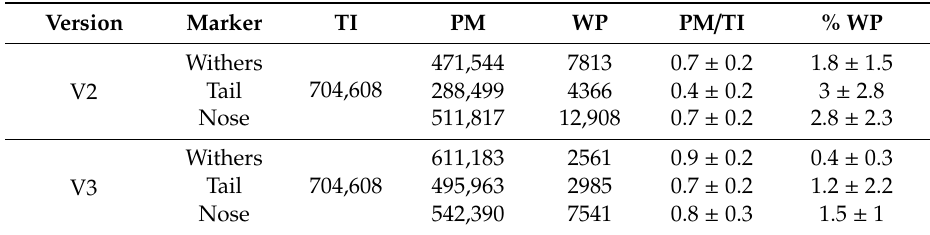
Table 1. Comparison of version 2 and version 3 in regard to total sums of predicted markers (PM) and wrongly predicted markers (WP), the ratio (PM / TI) of PM divided by total image (TI) and the percentage of wrongly predicted markers (%WP) in relation to number of predicted markers per video given as mean ± SD. Presented are data of the 39 training and test videos.